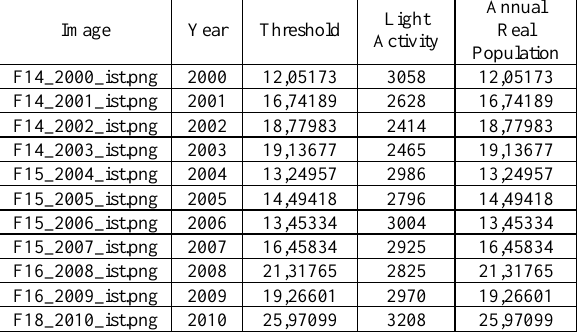
Table 1. Obtained threshold values and light activity values